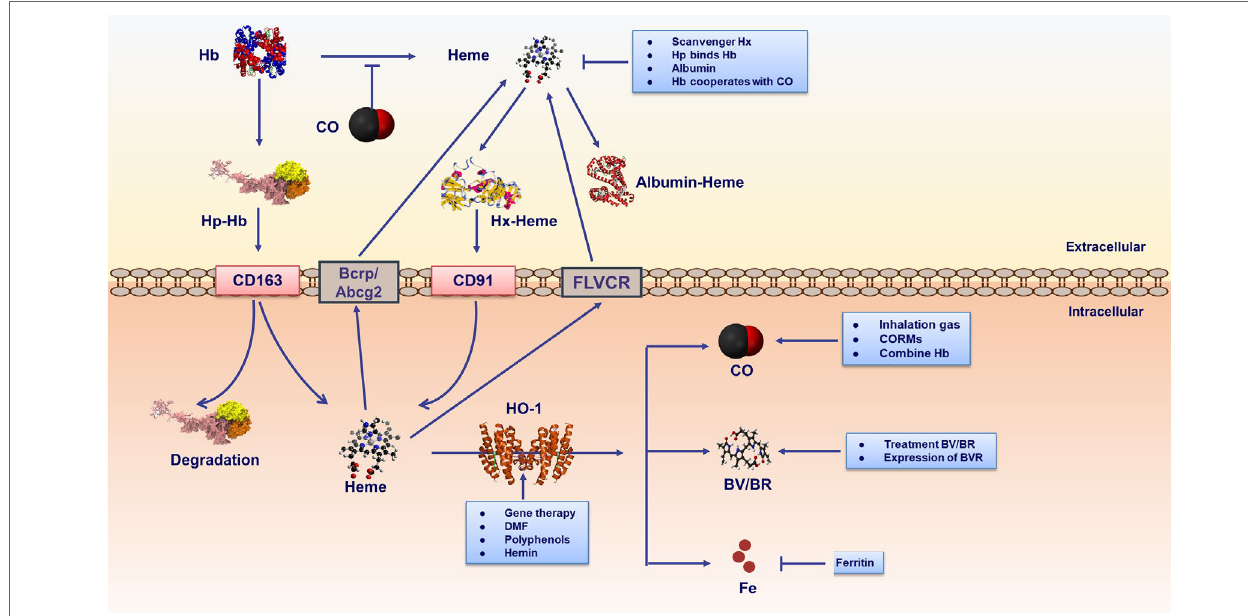
FIGURE 3 | Therapeutic strategies are involved in heme metabolic pathway. strategies include extracellular and intracellular ways. Extracellular mechanisms mainly conclude scavenger proteins haptoglobin (Hp)/hemopexin (Hx) binding hemoglobin (Hb)/free heme respectively. Furthermore, albumin binds free heme inhibiting its proinflammatory effects. Hp-Hb complex binds to CD163 receptor expressed on the cell membrane, leading to endocytosis and degradation of the Hb and Hp complexes. It is noteworthy that CO binding Fe 2+ in hemoproteins could prevent heme releasing. Heme-Hx complex is recognized by cell receptor CD91, delivering heme for catabolism by HO-1. The intracellular heme is degraded by HO-1. In addition, cellular heme levels could be excluded by heme efflux transporters FLVCR and Bcrp/Abcg2. Gene therapy and HO-1 inducers could regulate HO-1. HO-1 inducers contain natural (polyphenols) and synthetic (DMF) compounds. In addition, as the substrate of HO-1, hemin is a natural HO-1 inducer existing in human body. The labile ferrous iron released from heme catabolism is subsequently sequestered by ferritin, thus conferring cyto-protection against heme-Fe 2+ . The end products of HO-1 activity, namely BV/BR, and CO act as pharmacologic molecules. CO could be elevated by inhalation or through the use of CO-releasing molecules (CORMs). Additional therapy involving CO includes CO-binding hemoglobins. BV/BR treatment and BVR expression is also proposed as intervention